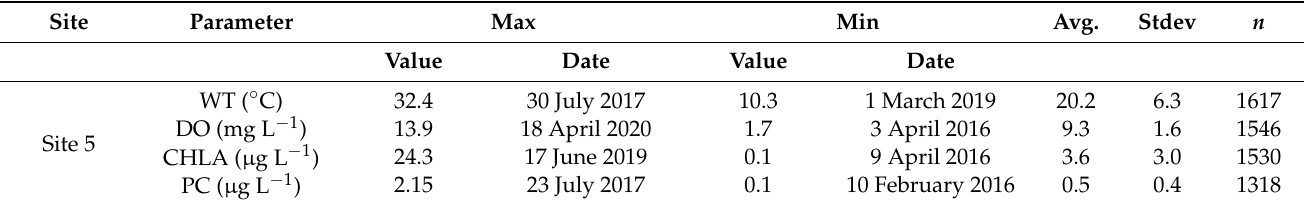
Table 3. Statistical summaries of surface WT, DO, CHLA and PC measured by monitoring buoys at site 5 and site